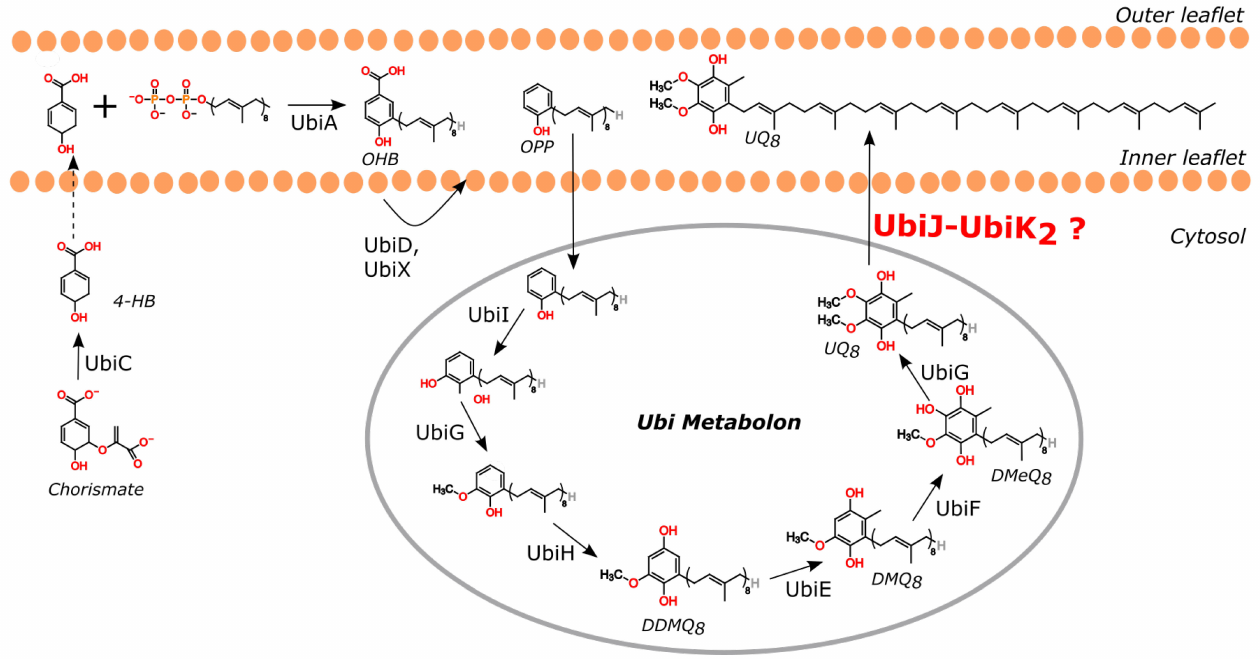
Figure 1. Ubiquinone biosynthesis pathway in E. coli supramolecular organisation. Molecules are represented in their reduced forms. Abbreviations: 4-HB: 4-hydroxybenzoate; OHB: octaprenyl- 4-hydroxybenzoate; OPP: octaprenyl phenol; DDMQ 8 : C2-demethyl-C6-demethoxy-ubiquinone 8; UQ 8 : Ubiquinone